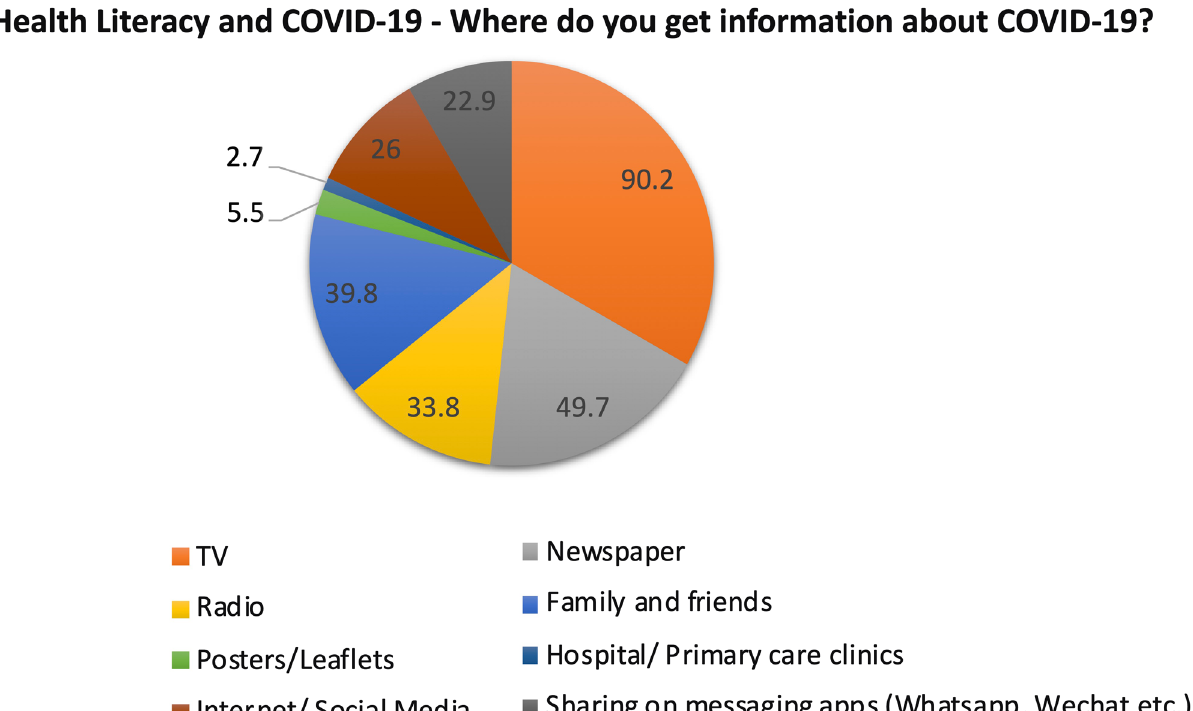
Figure 1. Variety of sources from which respondents get information on